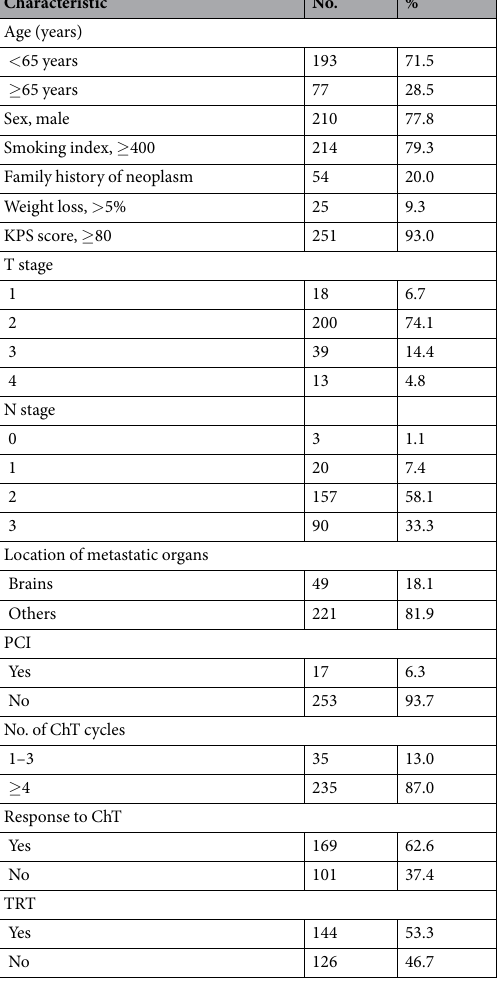
Table 1. Patient and disease characteristics of 270